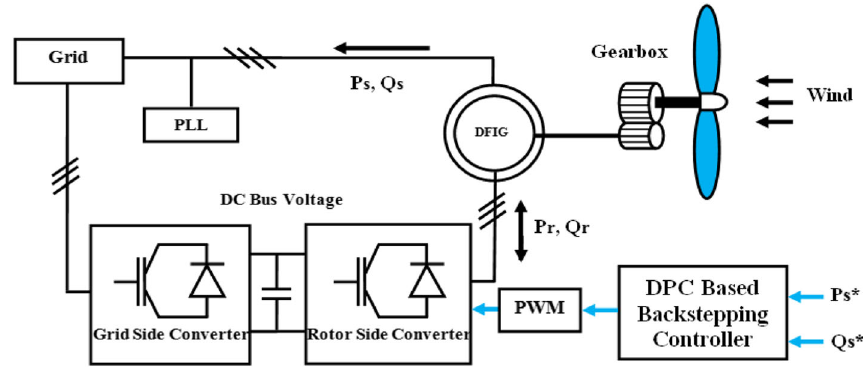
Fig. 1 Structure of wind energy Conversion system based on a DFIG